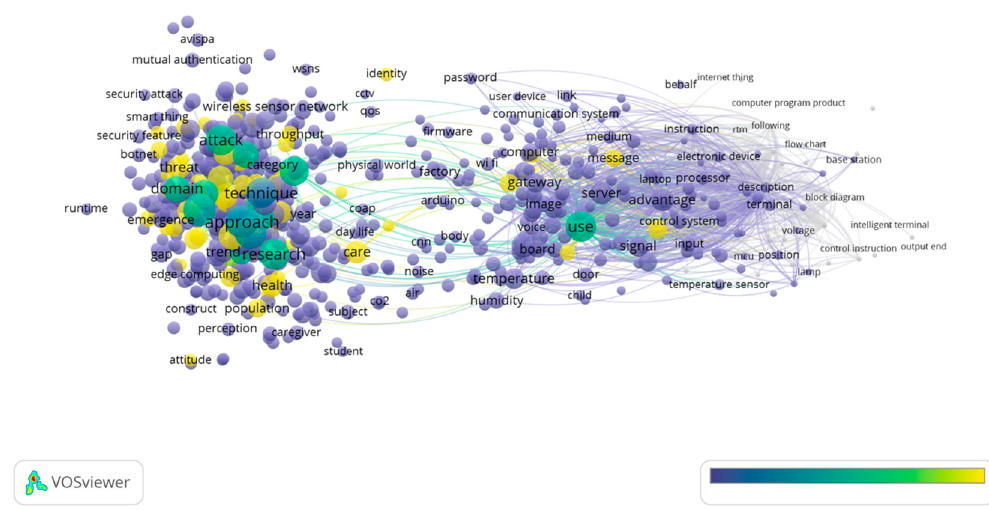
Figure 12. Themes overlay for 2019.